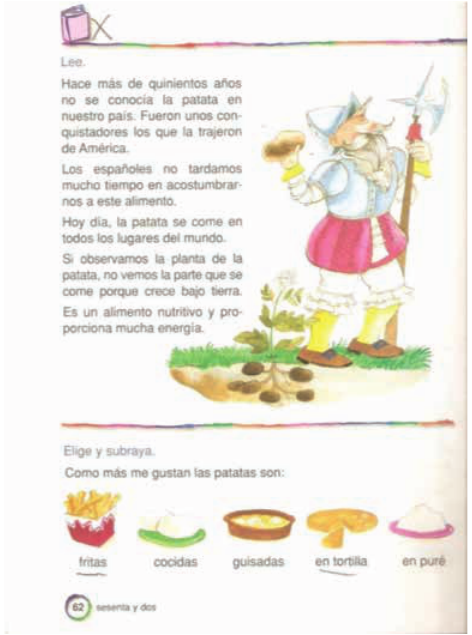
Figure 1: Global Method Stage One of Primary School, year 2000. Source: González and Sáenz de Urturi (2000: 62).